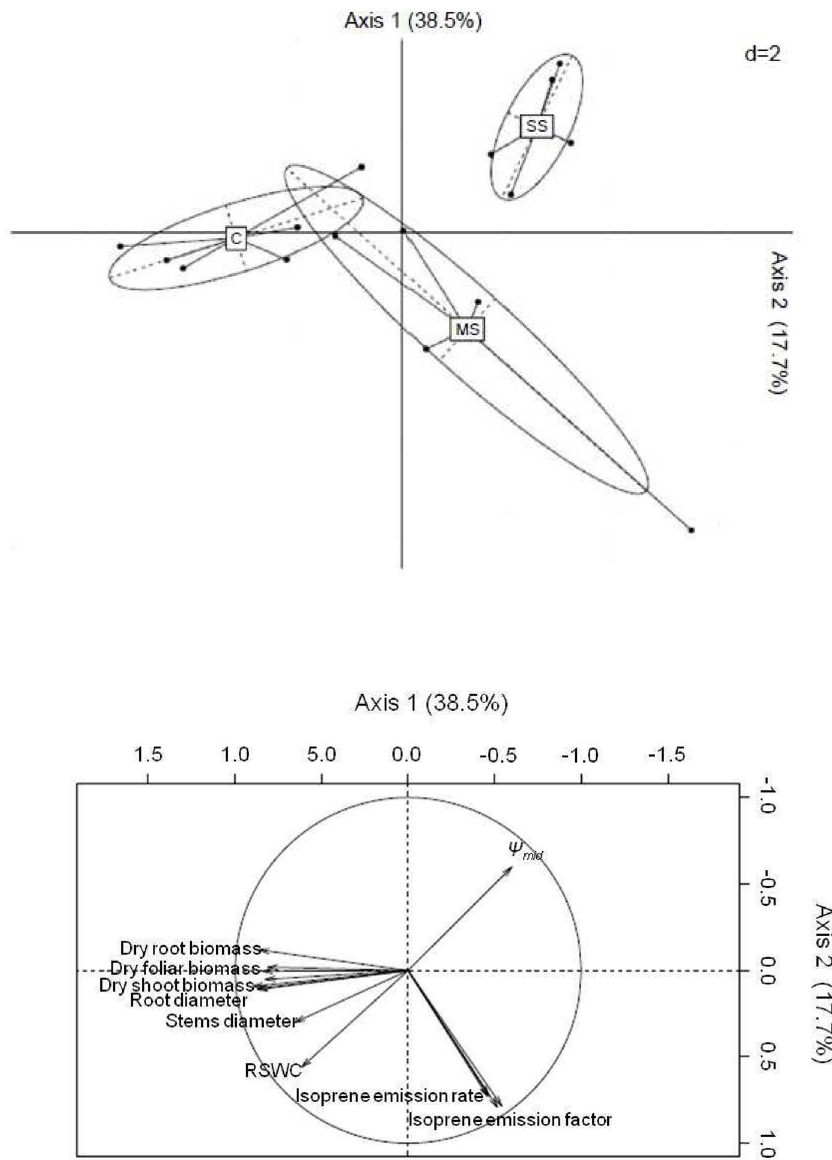
Figure 8. Leaf mass per area ratio. Seasonal course of the leaf mass per area ratio (LMA) under control (– X –), mild ( ) and severe ( ??? e ??? ) water stress. Differences are tested using a two-way ANOVA (F) repeated measurements followed by Tukey tests. Since interaction between seasonality and treatment is not significant according to the two-way ANOVA, results of water stress impact are shown in the small embedded graph where data of all months are pooled together and differences between treatments are denoted by capital letters (A . B) while seasonality impact is shown in the main graph (in lower case letters: a . b). Values are mean 6 SE of n=5 saplings.